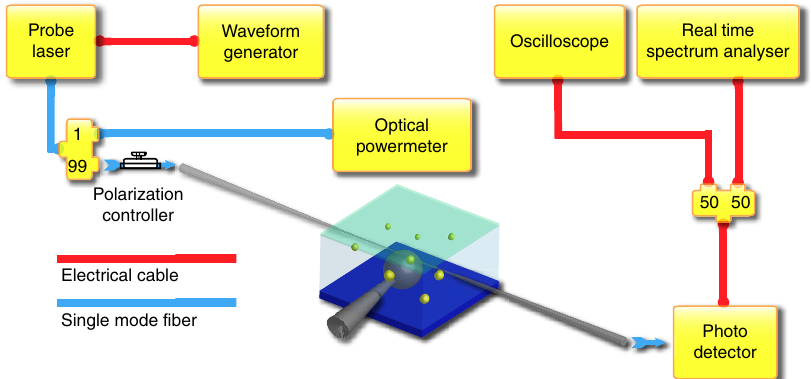
Figure 6 | Experiment set-up. Ninety-nine per cent of the laser light is delivered to the microcavity through a tapered optical fibre. The light escaped from the cavity is coupled back to the same fibre and captured by a photodetector. The captured signal is then converted to electrical signals and analysed by a spectrum analyser and an oscilloscope. Meanwhile 1% light is delivered to an optical power metre for monitoring purposes.